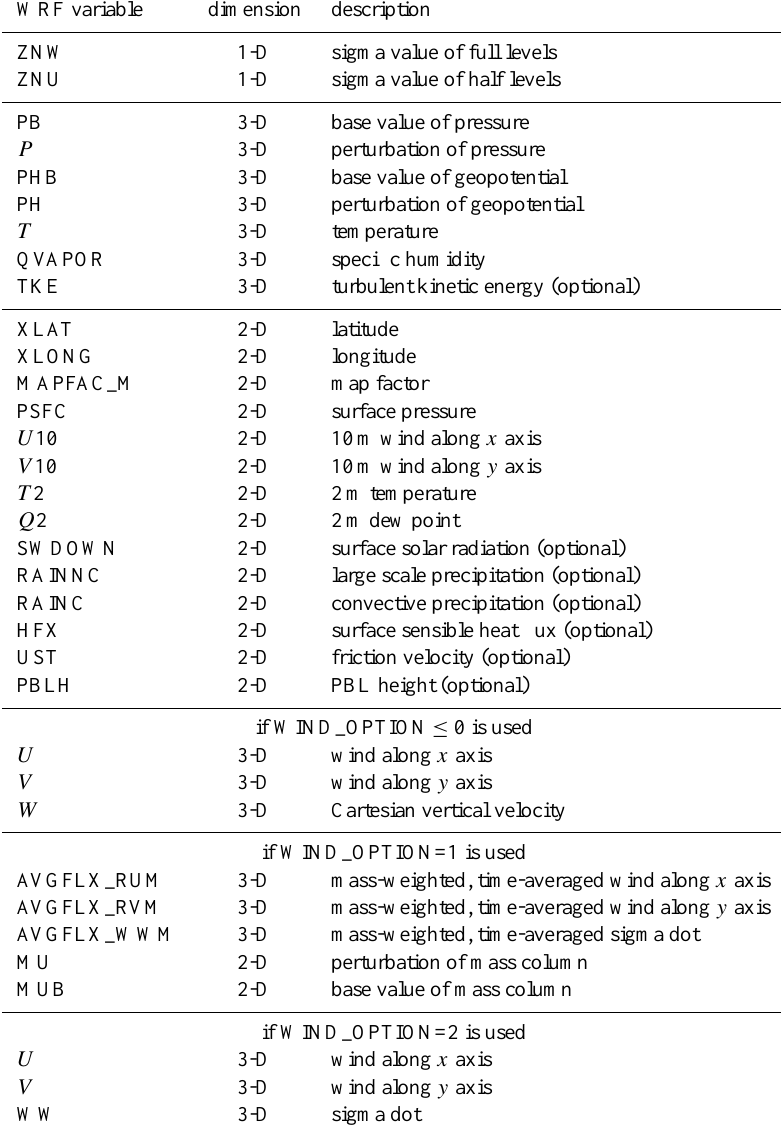
Table 1. List of variables needed from the WRF output to run FLEXPART-WRF. WRF variable